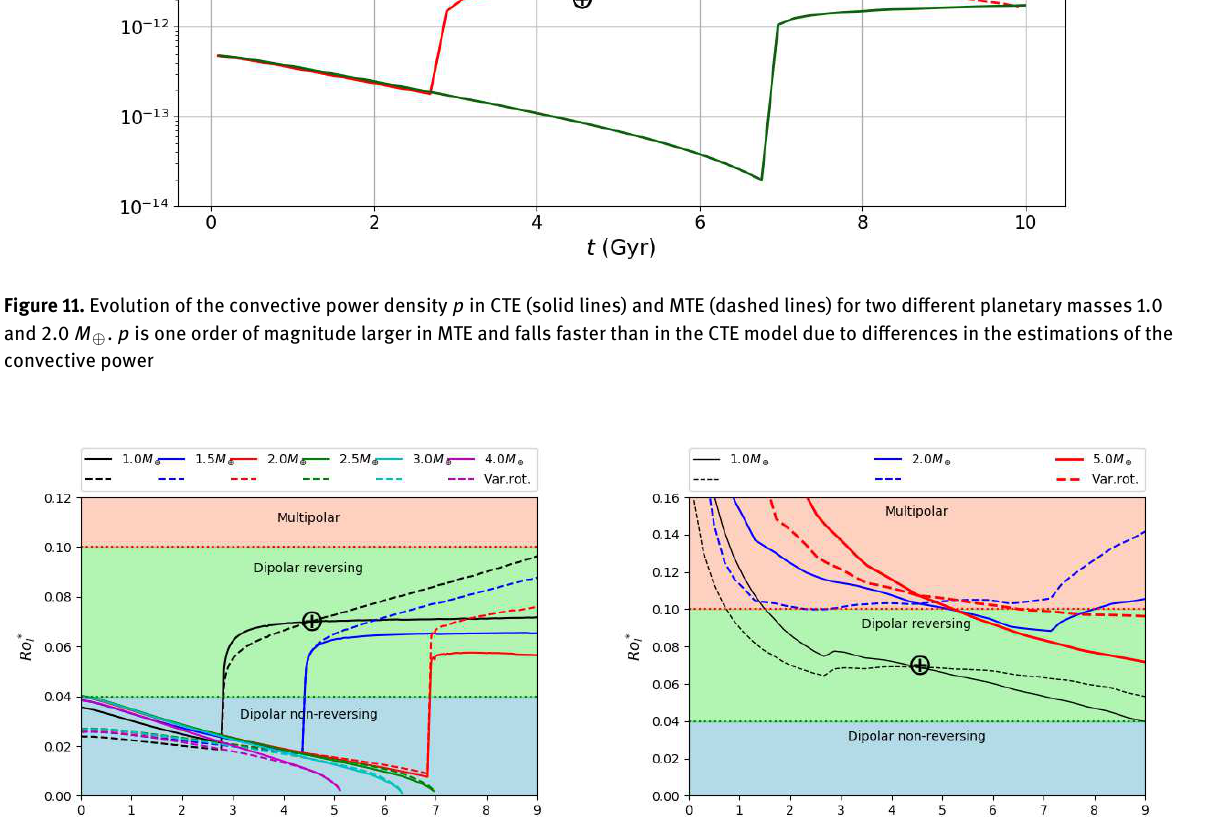
=1 d. For variable period of rotation o